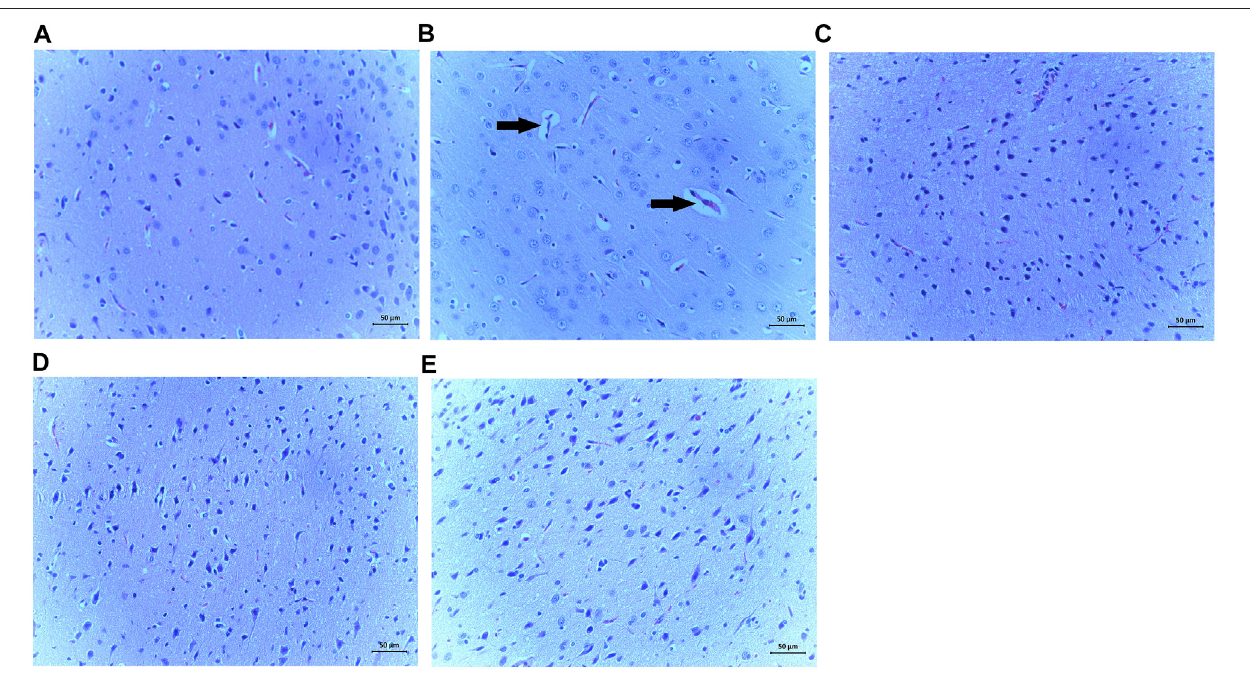
FIGURE 9 | Effect of SiPE treatment on histopathological features in HF/STZ-induced diabetic encephalopathic rats. Representative images of H&E staining of brain tissues showing (A) NCA group, (B) DECA group, (C) SiPE50 group, (D) SiPE100 group and (E) SiPE200 group. (magni fi cation × 200, scale bar (cid:2) 50 μ m).